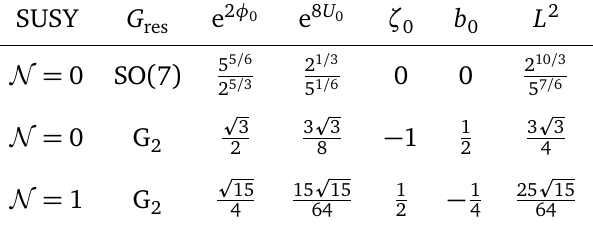
length at the critical points of the potential. 4